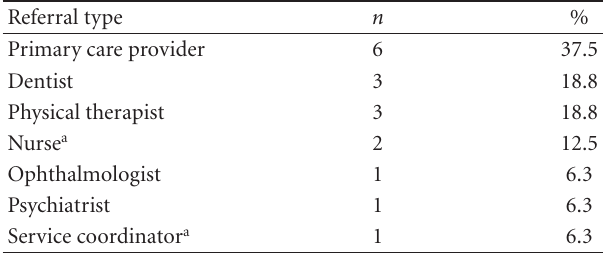
Table 7: Types of referrals made by gerontological nurse practi- tioner students following a geriatric and oral health screening in 2008 ( N =